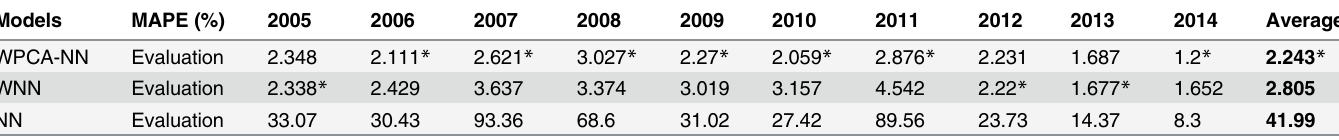
Table 5. Performance of the models, MAPE ratio of evaluation results for KOSPI futures. Models MAPE (%) WPCA-NN Evaluation Evaluation Evaluation